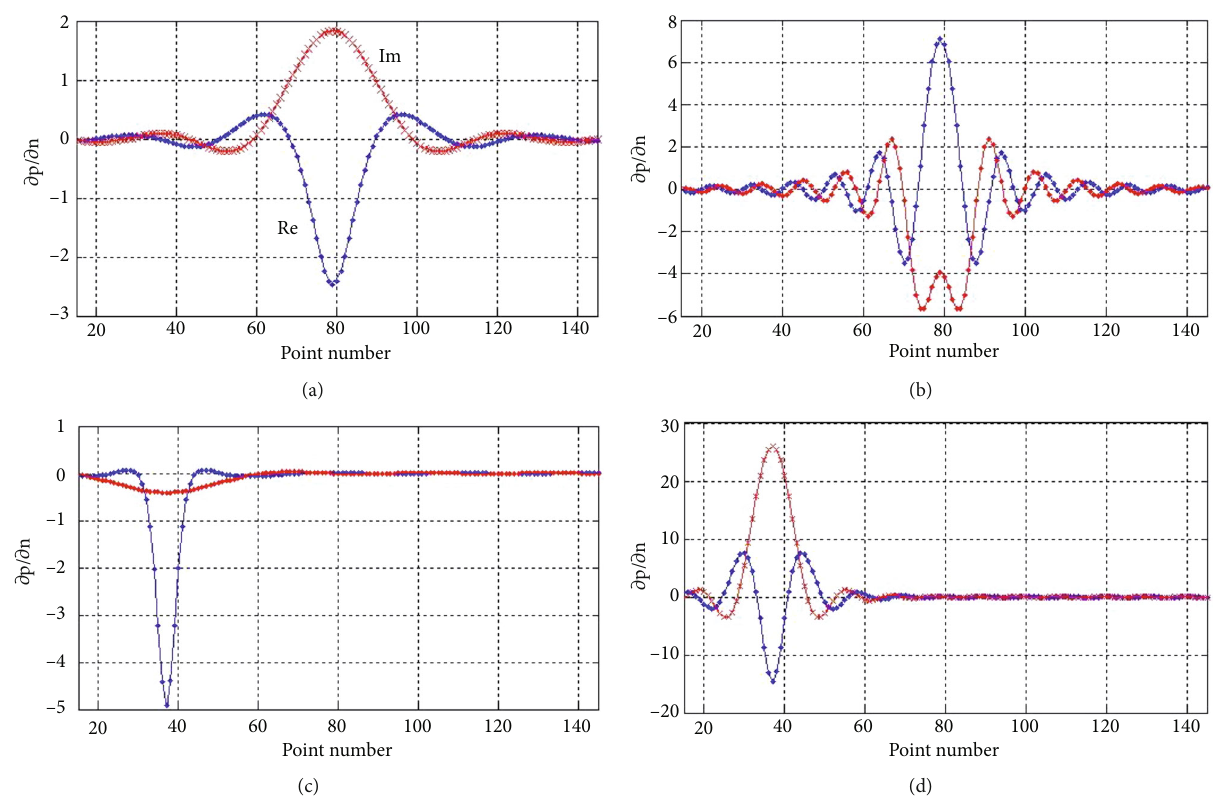
Figure 3: The result of testing the impedance matrix in the model problem. The diagrams show the projection of the pressure gradient of the test source fi eld on the outer normal to the cylindrical surface: real and imaginary parts (see the text for